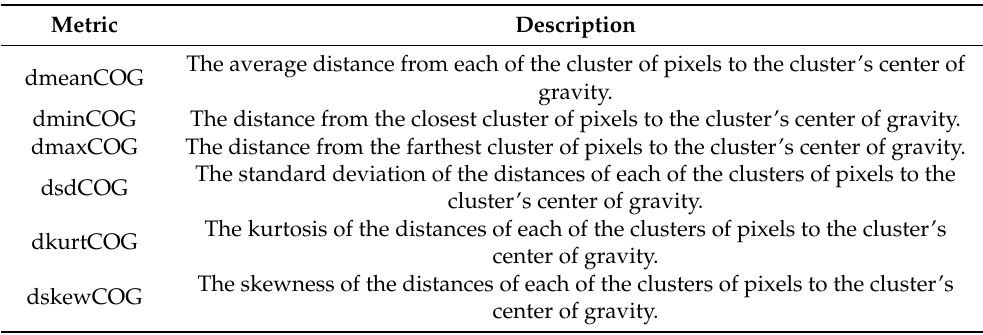
Table 2. Set of metrics calculated for each detected disturbance cluster to study the position of pixels in the cluster in relation to the center of gravity of the